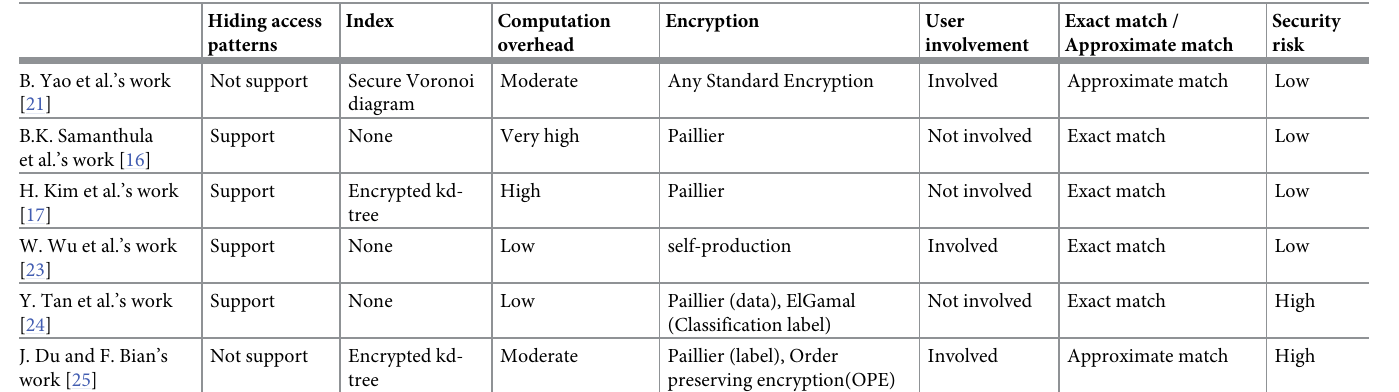
Table 1. Comparison of existing studies.